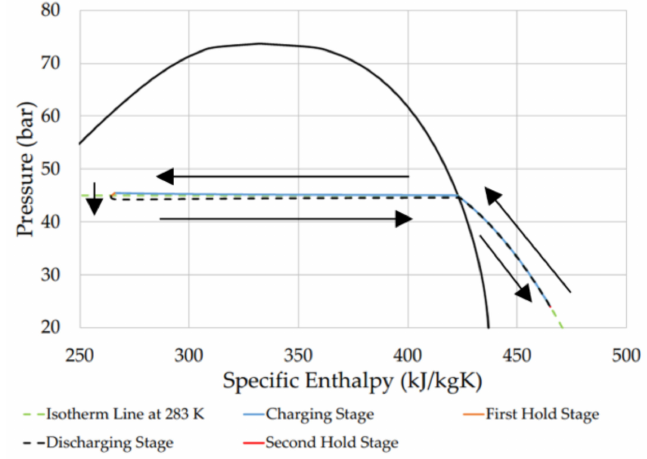
Figure 5. Pressure (bar) against specific enthalpy (kJ/kg · K) for CO 2 -based accumulator having high convective heat transfer coefficient, with the black lines representing the liquid–vapor dome for CO 2 and the arrows indicating direction of cycle.